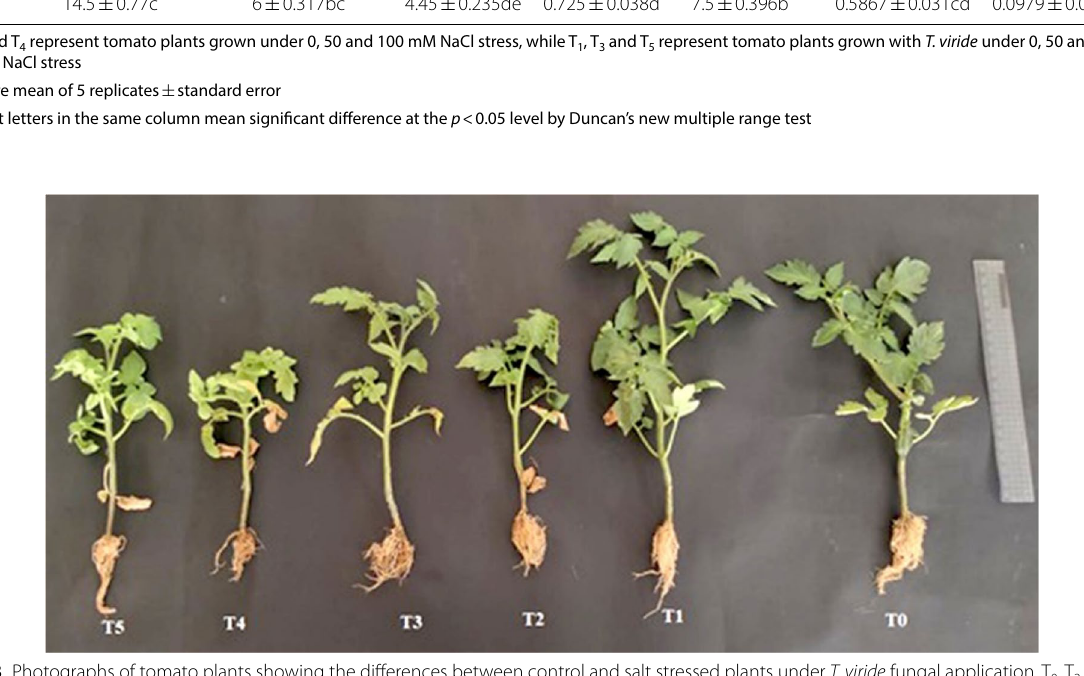
Fig. 8 Photographs of tomato plants showing the differences between control and salt stressed plants under T. viride fungal application. T 0 , T 2 and T 4 represent tomato plants grown under 0, 50 and 100 mM NaCl stress, while T 1 , T 3 and T 5 represent tomato plants grown with T. viride under 0, 50 and 100 mM NaCl